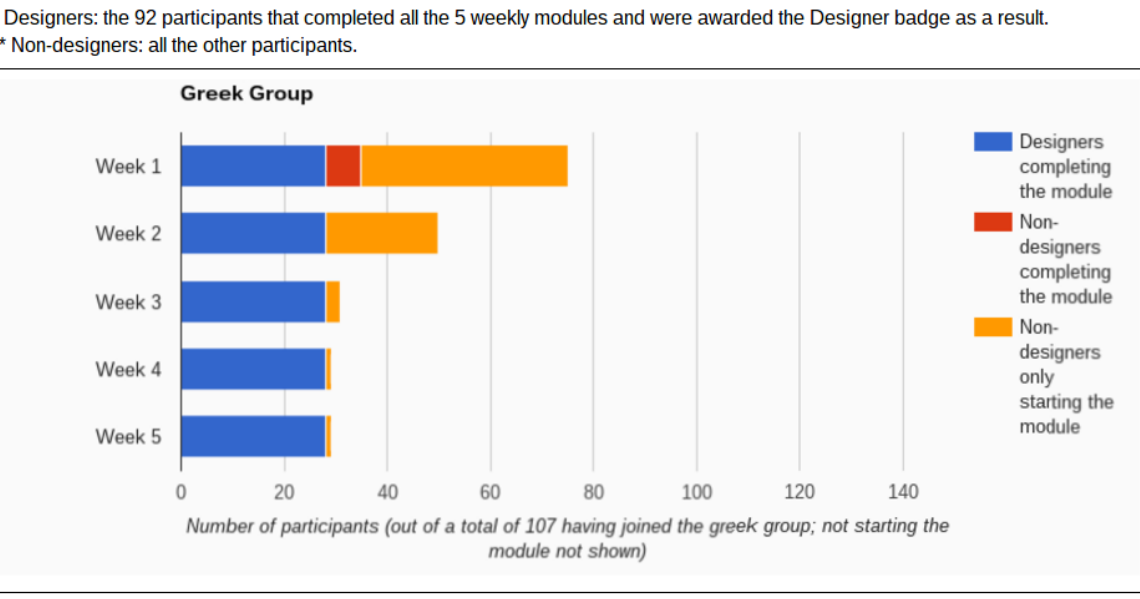
Figure 7 . Greek group: Participation in weekly modules of